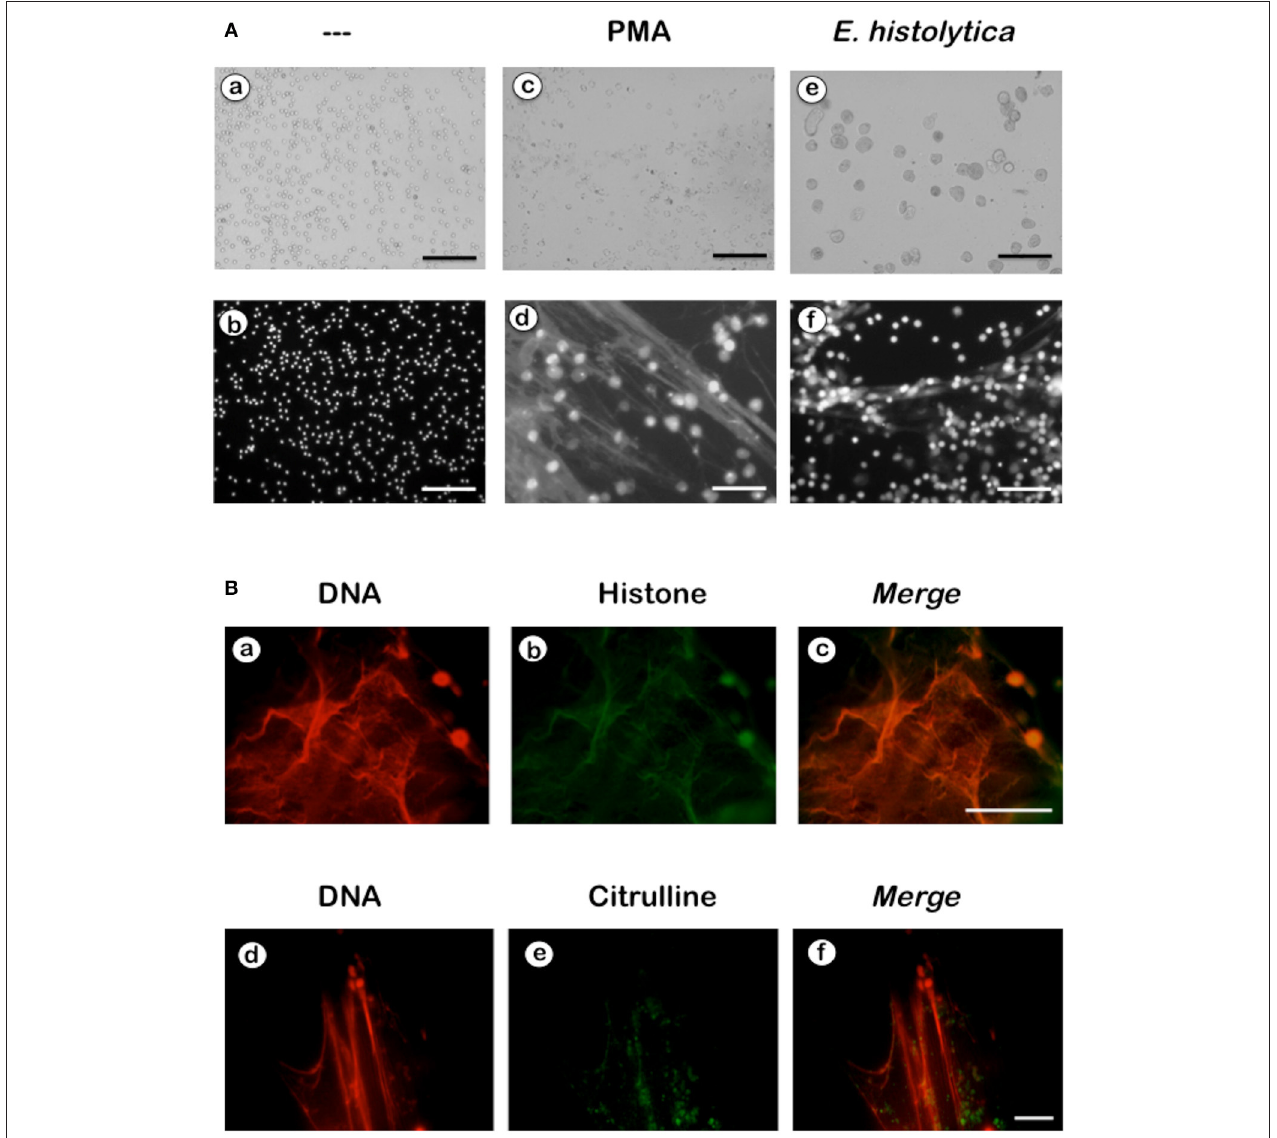
FIGURE 1 | Entamoeba histolytica induce NETs formation. (A) Human neutrophils (PMN) were left untreated (—), or were stimulated with 20 nM phorbol 12-myristate 13-acetate (PMA), or by E. histolytica trophozoites (amoeba to PMN ratio 1:20). After 4h, cells were fixed and stained for DNA with DAPI. Microphotographs were taken with white light (a,c,e) or with fluorescent light (b,d,f) and are representative of more than 10 experiments. Scale bar is 100 µ m. (B) Human neutrophils were stimulated with trophozoites during 4h at 37 ◦ C. Cells were fixed and immunofluorescence was performed using anti-histone H4 or anti-citrulline antibodies followed by TRITC-conjugated anti-rabbit IgG antibody. DNA was stained with DAPI. Scale bar 50 is µ